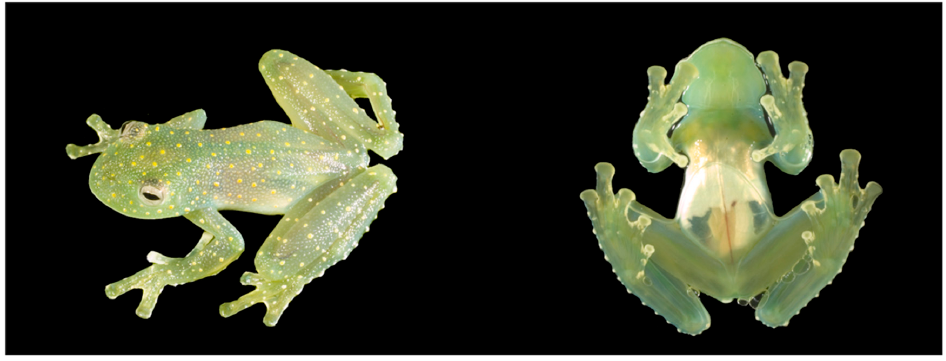
Figure 74. Cochranella mache in life. Adult male, QCAZ 27764, from Río La Carolina, 500 m, Esmeraldas province, Ecuador. Photos by Luis A. Coloma.